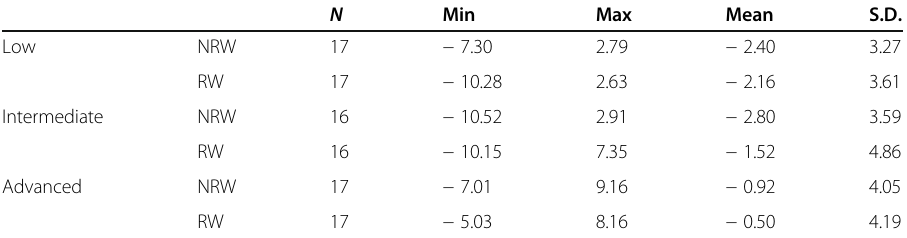
Table 8 Test performance scale logit by proficiency (rater effect removed) N Min Max Mean S.D. Low